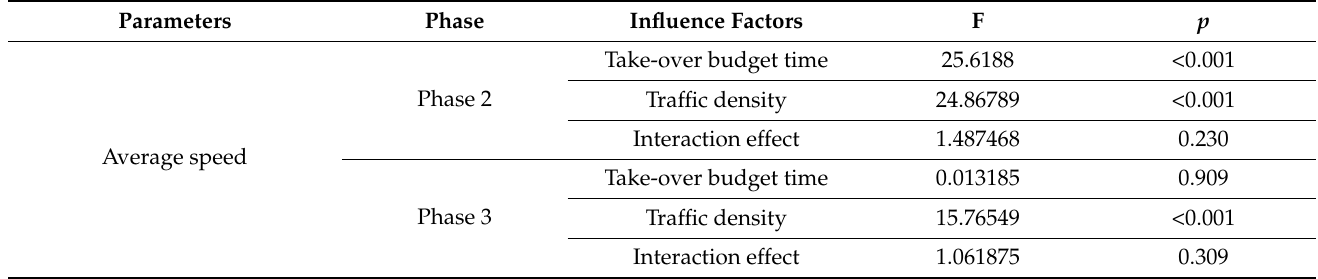
Table 4. Influence of take-over budget time and traffic density on longitudinal dynamics parameters.